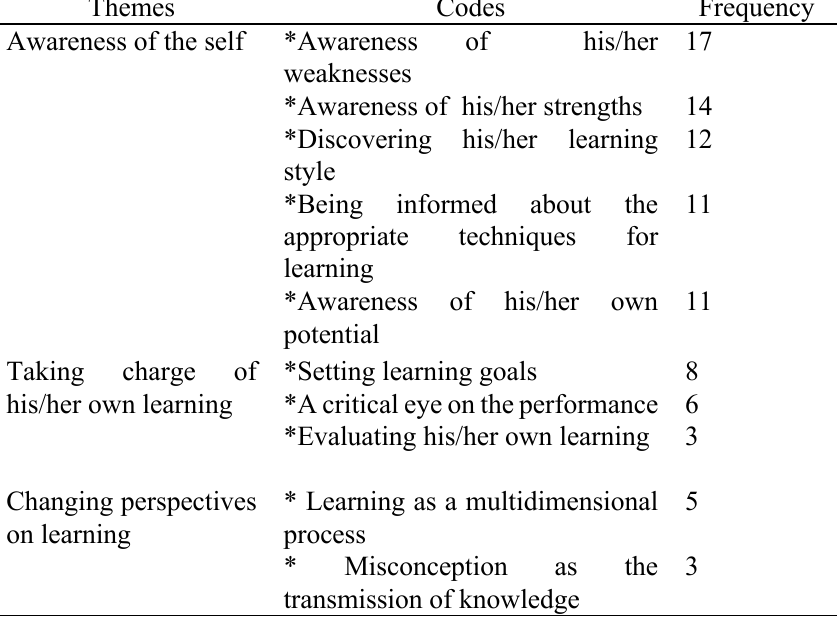
Table 2. Findings derived from the reflection reports and